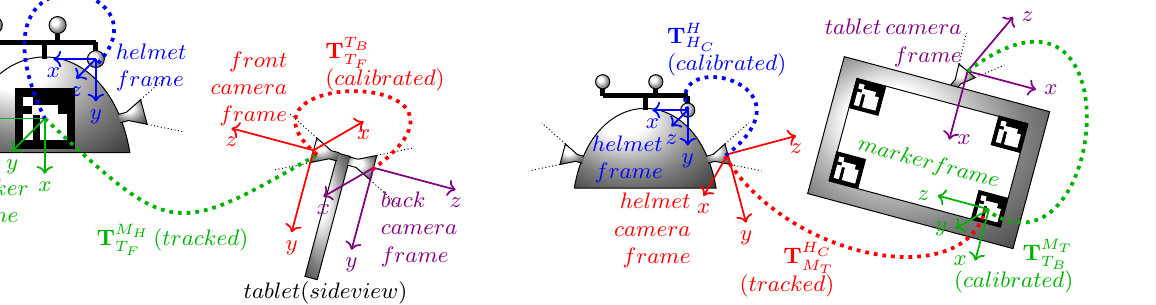
Figure 2. Tracking the relative pose between tablet and helmet by observing an ArUco marker mounted on the helmet from the front camera of the tablet.